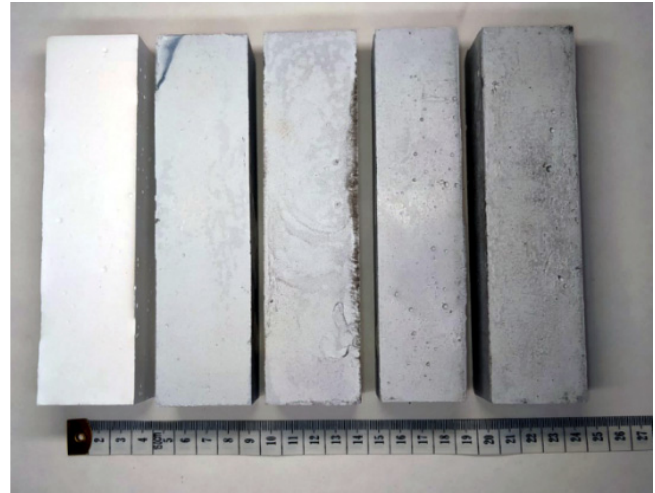
Figure 1. The photograph of the prepared prismatic specimens; from left MOC-REF, MOC-REF-CNT-0.2, MOC-CNT-10, MOC-CNT-D20 and MOC-CNT-D30.